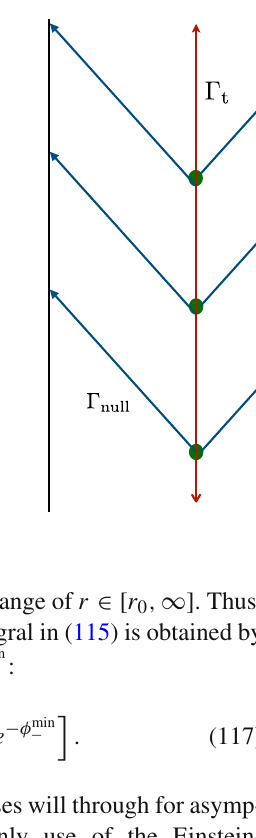
φ min = min { φ ± ( r ) } in the same range of r ∈ [ r ±